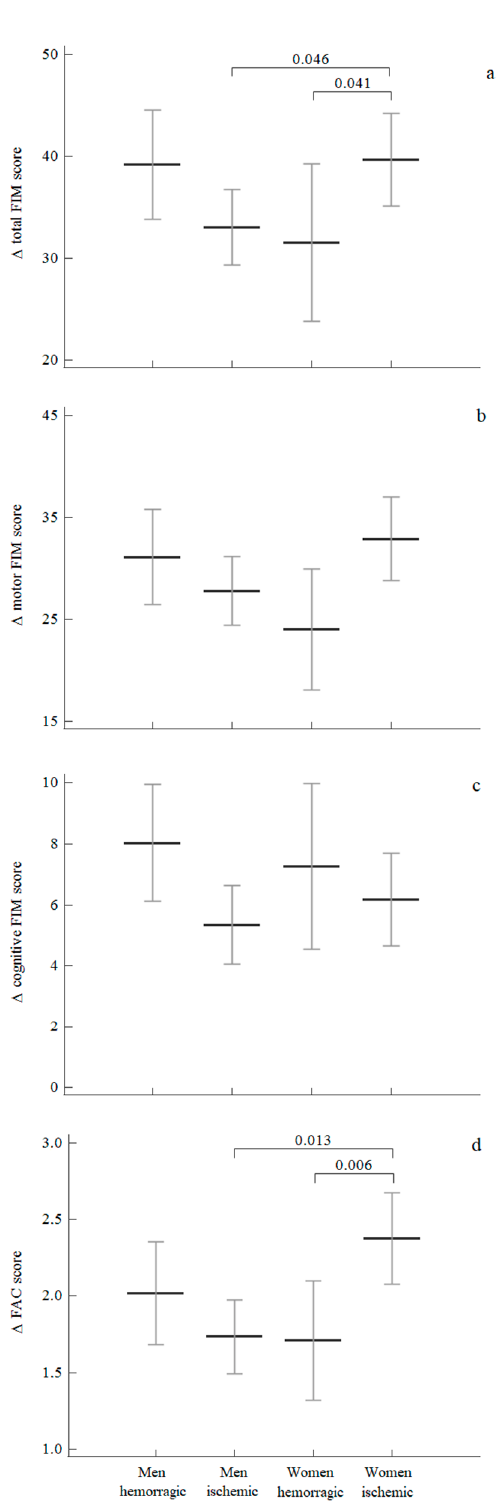
Figure 2. Mean and 95% confidence interval for ( a ) FIMtotal, ( b ) FIMmotor, ( c ) FIMcognitive and ( d ) FAC variations after rehabilitation in the two groups categorised by stroke type. Legend: Between-group comparison performed through Kruskal–Wallis tests.